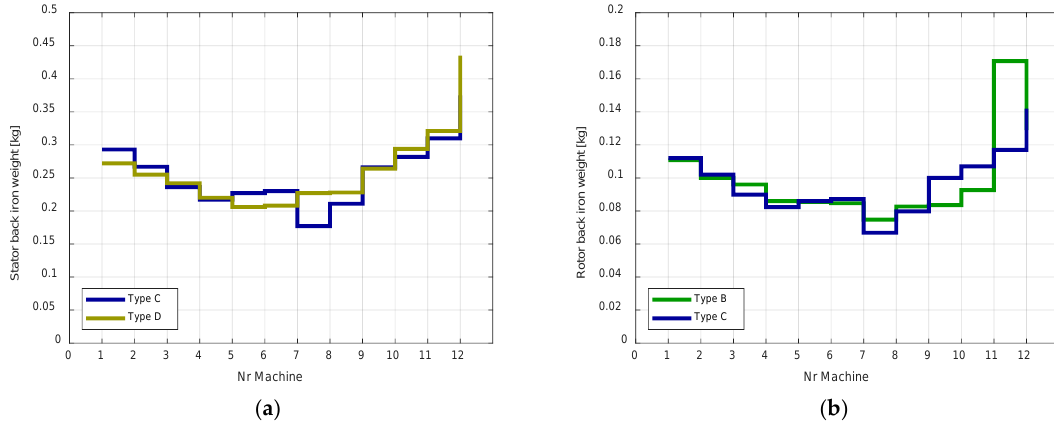
Figure 15. Stator ( a ) and rotor ( b ) magnetic yokes weights of the machines belonging to the Pareto fronts.